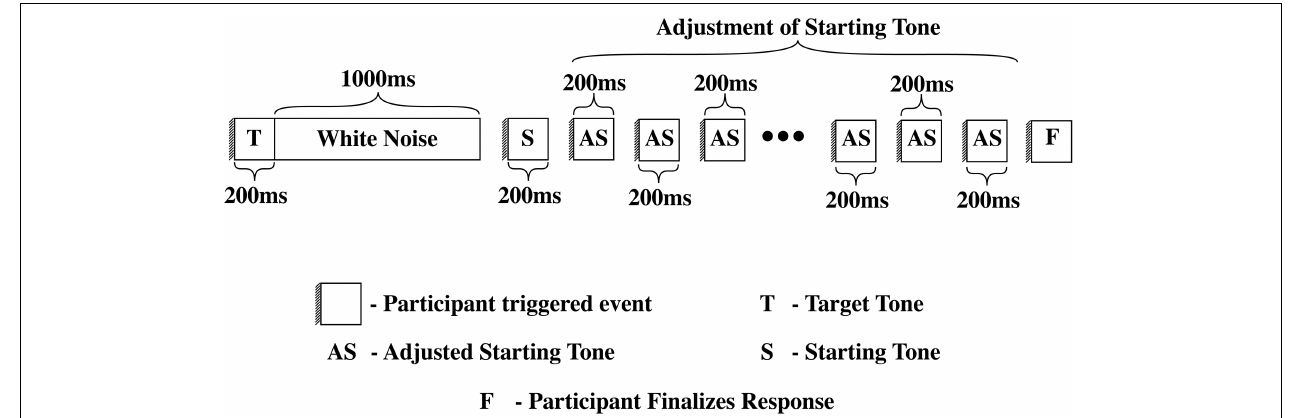
FIGURE 1 | On each trial, participants heard the target tone by clicking a circle with a T on it. This tone lasted 200ms and was followed by 1000ms of white noise. Individuals then heard the starting tone by clicking a circle with an S on it. There was no time limit between when the subjects heard the target tone to when they clicked the circle with an S on it to hear a starting tone. Individuals were then